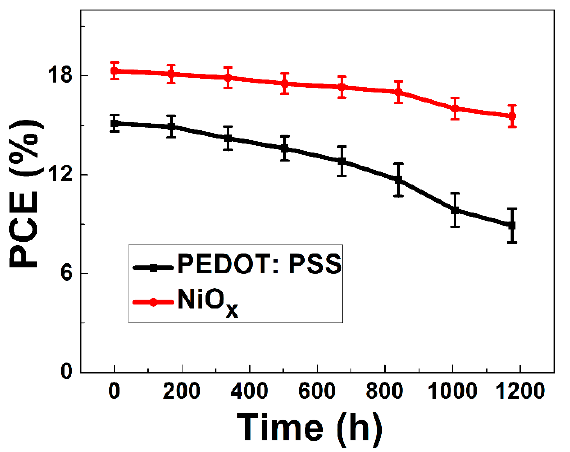
Figure 8. The long-term perovskite device stability fabricated for the PEDOT:PSS (black line) and NiO x (red line) HTLs has been tested for 1200 h at 40% relative humidity (RH) and 25 °C.